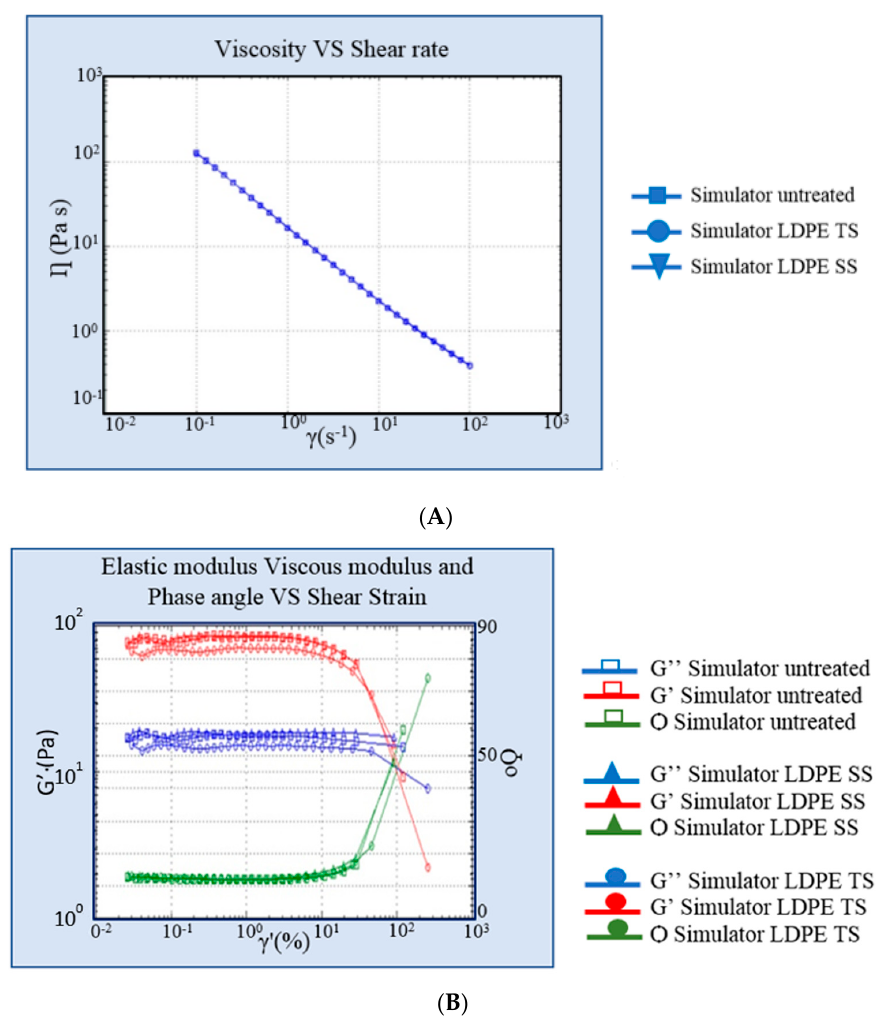
Figure 6. ( A ) Viscosity curve of simulant in low-density polyethylene (LDPE) vs. untreated simulant. ( B ) Elastic and viscous modulus curves of simulant in LDPE vs. untreated simulant. SS: simulated solar irradiation, TS: thermal shock.